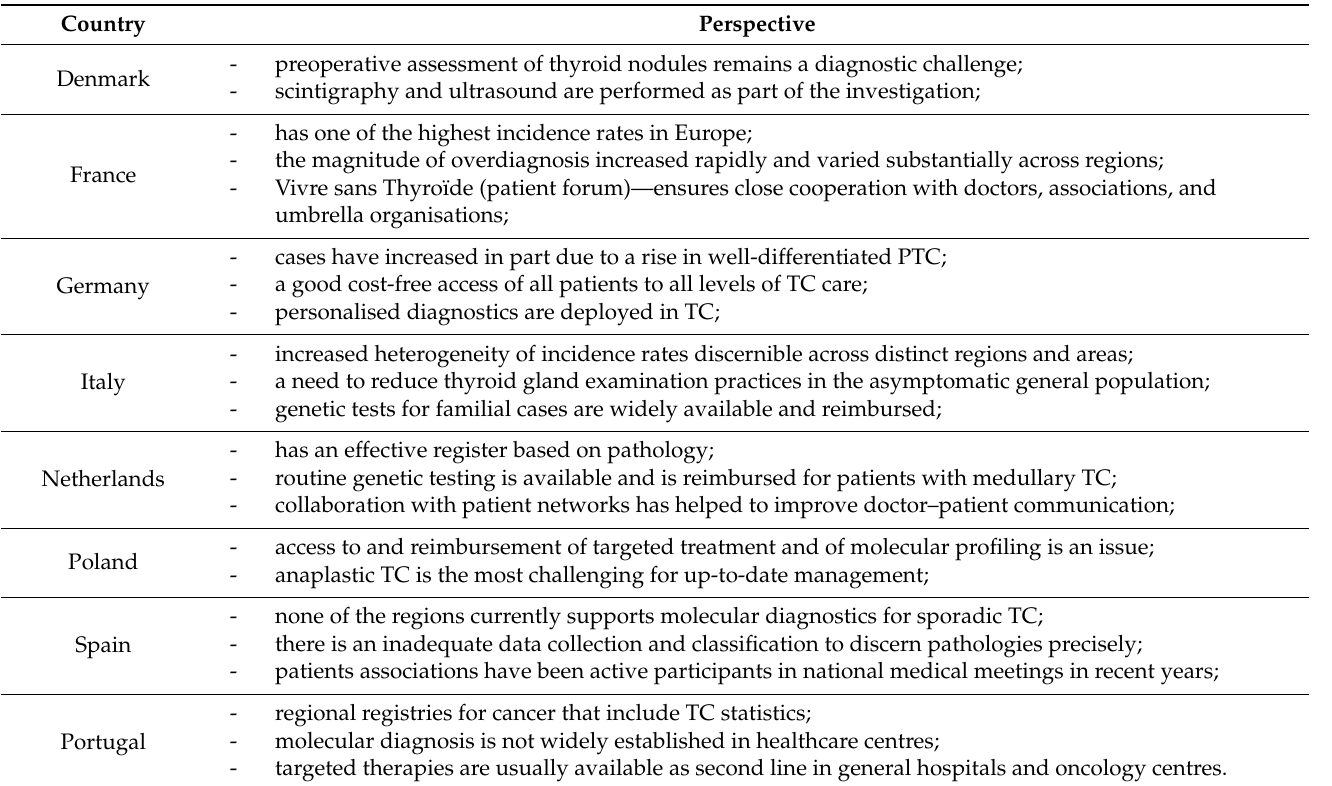
Table 2. Some national perspectives in tackling TC emerged from the EAPM